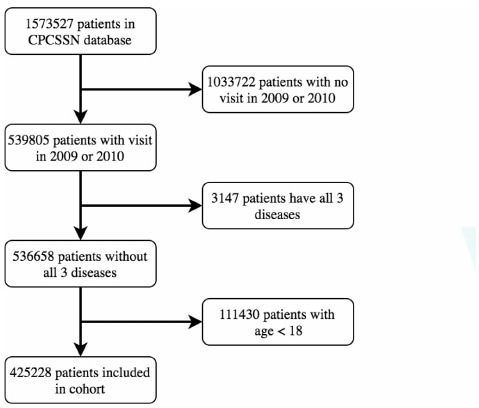
Figure 1: Cohort based on CPCSSN